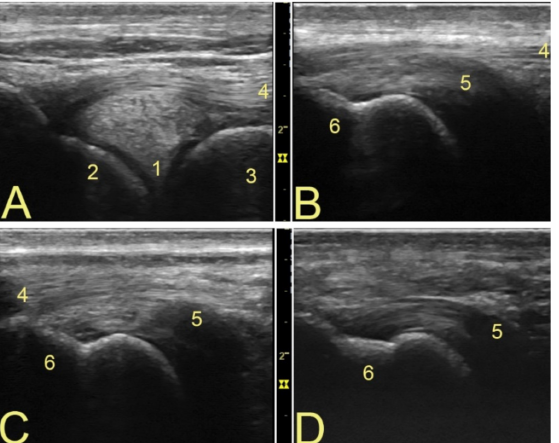
Figure 3. Insertion variants of the popliteal tendon. The type of insertion of the PopT depends to its relation to the LCL [7]. Proximal to the left. ( A ) Lateral meniscus and LCL. ( B ) Cranial insertion of the PopT, the LCL cannot be fully visualized when the full width of the tendon is visible. ( C ) When the insertion of the PopT is located underneath the LCL, the latter structure is clearly seen in the image. ( D ) Caudal insertion of the PopT, as the probe had to be displaced caudally (Supplementary Materials Video S1), the LCL is no longer visible while the full width of the tendon is. Annotations: 1—lateral meniscus; 2—lateral femoral condyle; 3—tibia; 4 LCL; 5—PopT; 6—lateral femoral